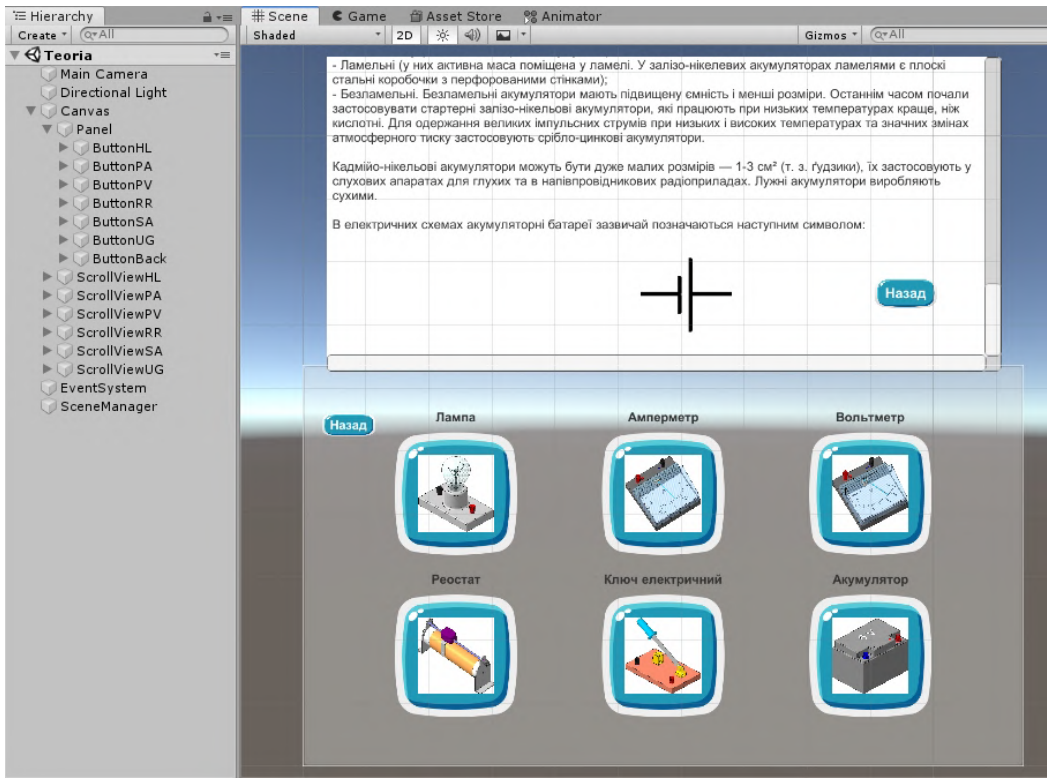
Figure 6: Scene of theoretical